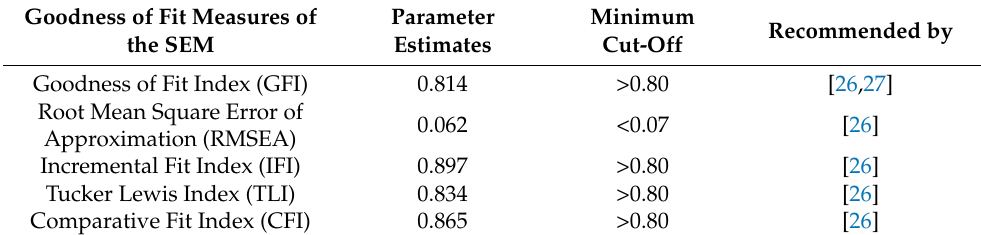
Table 3. Final model fit.